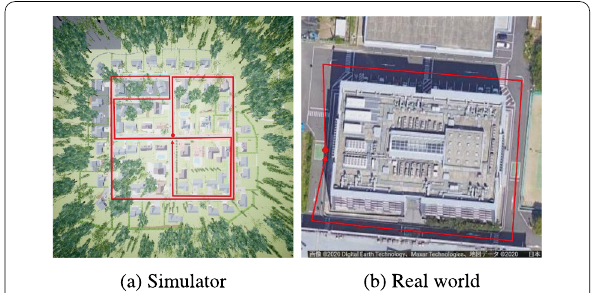
Fig. 11 Driving courses. The AirSim’s drone flew for about 9 min in ( a ). The sensors were carried for about 5 min in ( b